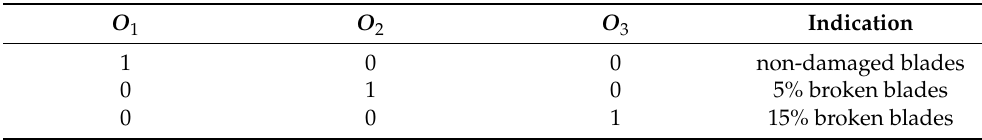
Table 2. LSTM output definitions.